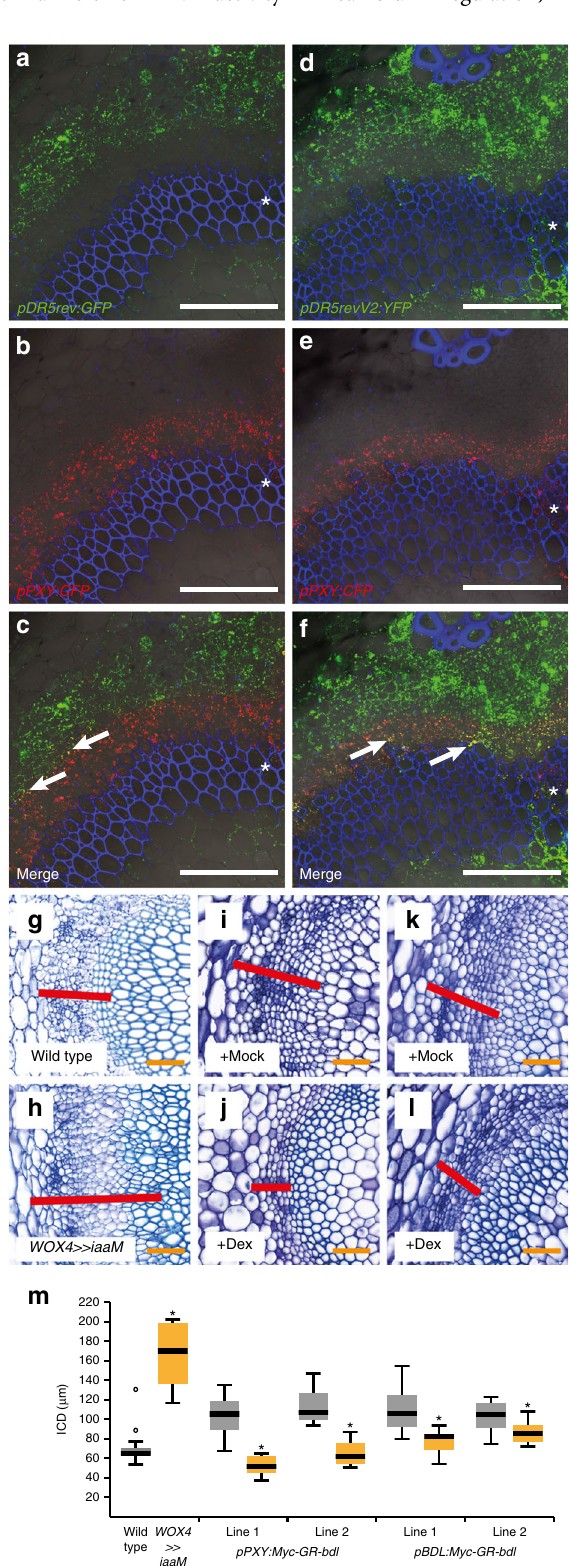
Fig. 1 : Auxin signalling is required in cambium stem cells. a – f Confocal analyses of stem bases from plants containing the auxin response markers pDR5rev:GFP ( a – c ) or pDR5revV2:YFP ( d – f ) and the stem cell marker pPXY: CFP . Overlapping foci between pPXY:CFP (red) and the respective auxin response marker activities are marked by arrows ( c , f ). Asterisks mark the vascular bundles. Size bars represent 100 µ m. Propidium iodide (PI) staining in blue. g – l Toluidine blue stained cross sections at the stem base of wild type ( g ) pWOX4:AlcR; pAlcA:iaaM ( h ), pPXY:Myc-GR-bdl ( i , j ) and pBDL:Myc-GR-bdl ( k , l ) plants after long-term EtOH ( g , h ), mock ( i , k ) or Dex ( j , l ) treatment. Interfascicular regions are shown and interfascicular cambium-derived tissues (ICD) are marked (red bar). Size bars represent 50 µ m. m Quanti fi cation of ICD tissue extension at the stem base of wild type, pWOX4:AlcR; palcA:iaaM (WOX4»iaaM), pPXY:Myc-GR-bdl and pBDL: Myc-GR-bdl plants after long-term EtOH (wild type and WOX4»iaaM ), mock (grey) or Dex (yellow) treatment. Student ’ s T -test ( pPXY:Myc-GR-bdl (line 2) p = 9.82E-06 and pBDL:Myc-GR-bdl p = 0.001 and p = 0.03) or Welch ’ s T -test (wild type and WOX4»iaaM p = 9.24E-09 and pPXY:Myc- GR-bdl (line 1) p = 5.2E-06) were performed comparing wild type and WOX4»iaaM and mock and Dex, respectively (Sample sizes n = 8 – 16). The T-bars that extend from the boxes (whiskers) are expected to include 95% of the data. Signi fi cance is indicated by